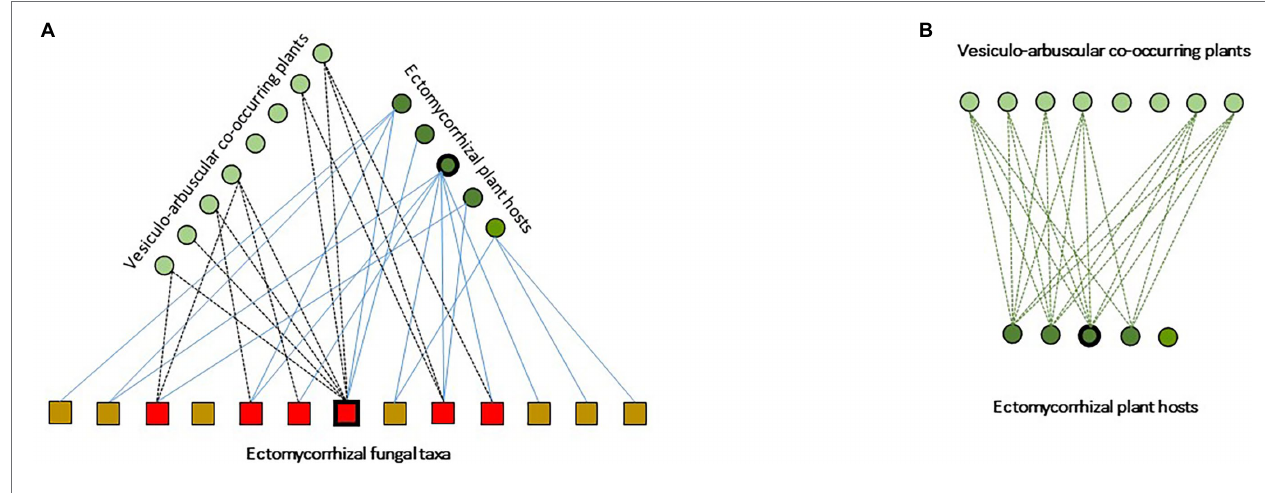
FIGURE 2 | Schematic representation of ectomycorrhizal-based multipartite networks in Tuber s sp. temperate agroforests, from Schneider-Maunoury et al. (2018) modified. (A) Species of co-occurring ectomycorrhizal and arbuscular mycorrhizal plants are represented by dark and clear green dots, respectively. The different taxa of ECM fungi are represented by squares. Interaction hubs are indicated by thickened outlines (here, Quercus ilex and Tuber melanosposrum ). Solid lines indicate plant-fungi ECM interaction links. Dotted lines indicate interaction links between ECM fungal tava and VA plants. (B) Schematic representation of the corresponding projected VA-ECM plant